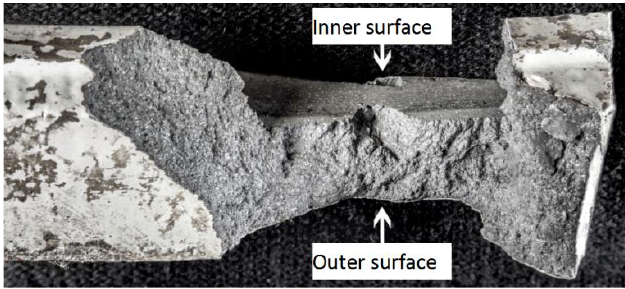
Figure 6. Fracture surface morphology of the hinged plate.